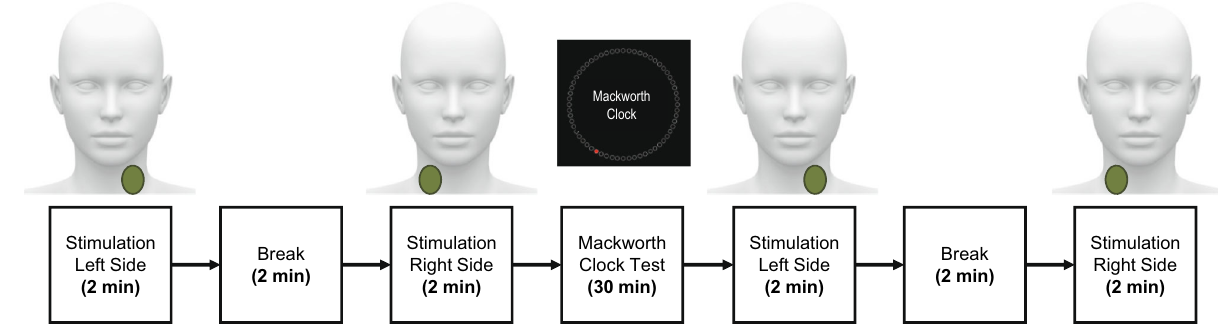
Fig. 6 Flow chart of ctVNS delivery during session 2 occurring at 1900 (7:00 PM Local). Illustration of ctVNS stimulation paradigm used during session 2 at 1900 (7:00 PM